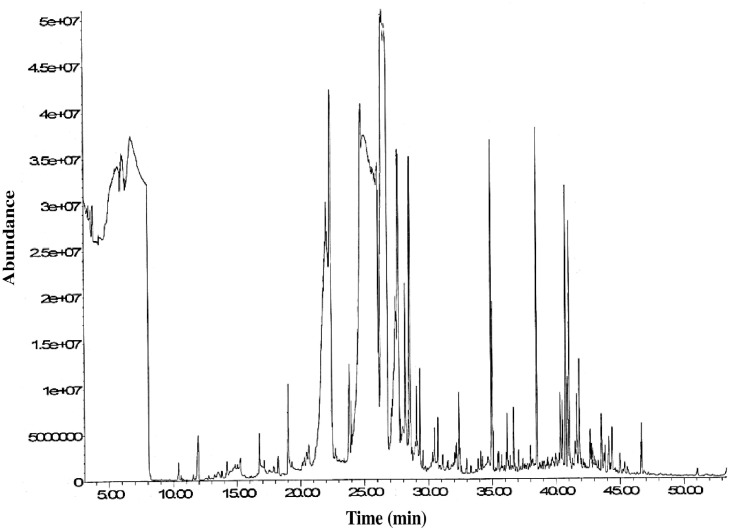
Gas chromatogram-Mass spectroscopy of A. catechu leaf extract.